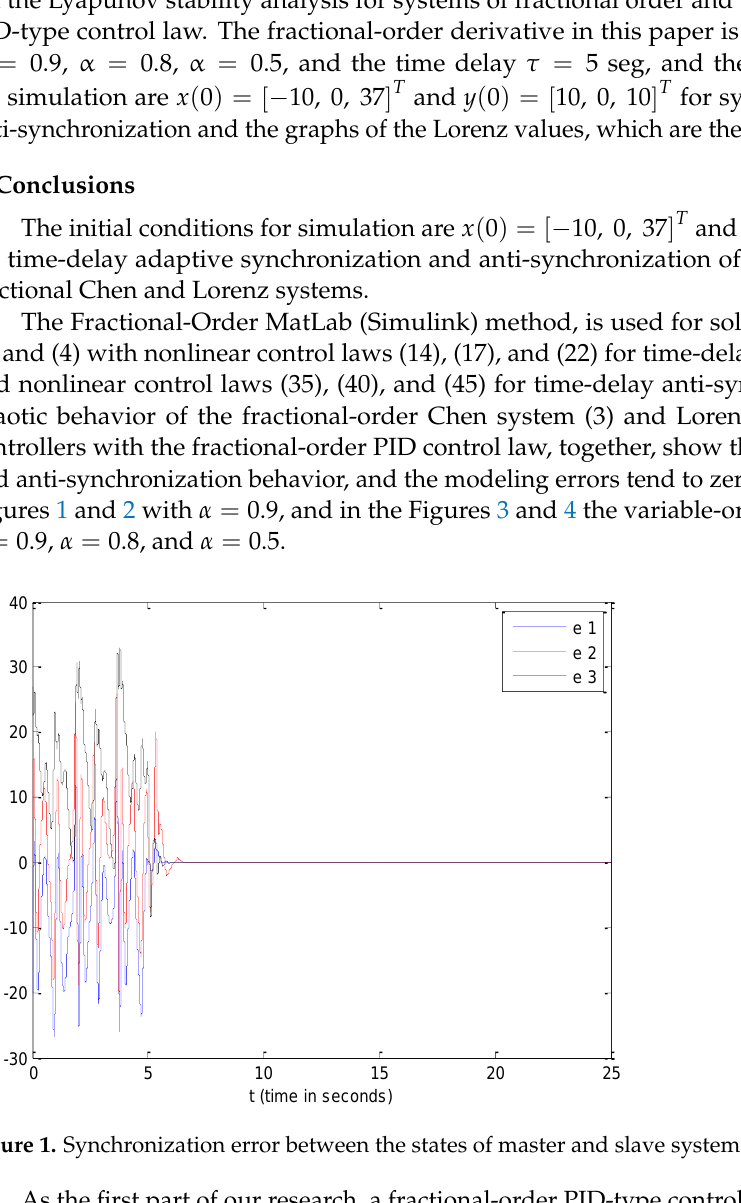
Figure 2. Anti-synchronization error between the states of master and slave systems with 𝛼 𝑖 = 0.9,𝑖 = 1,2, and 3 , and time delay 𝜏 = 5 s.